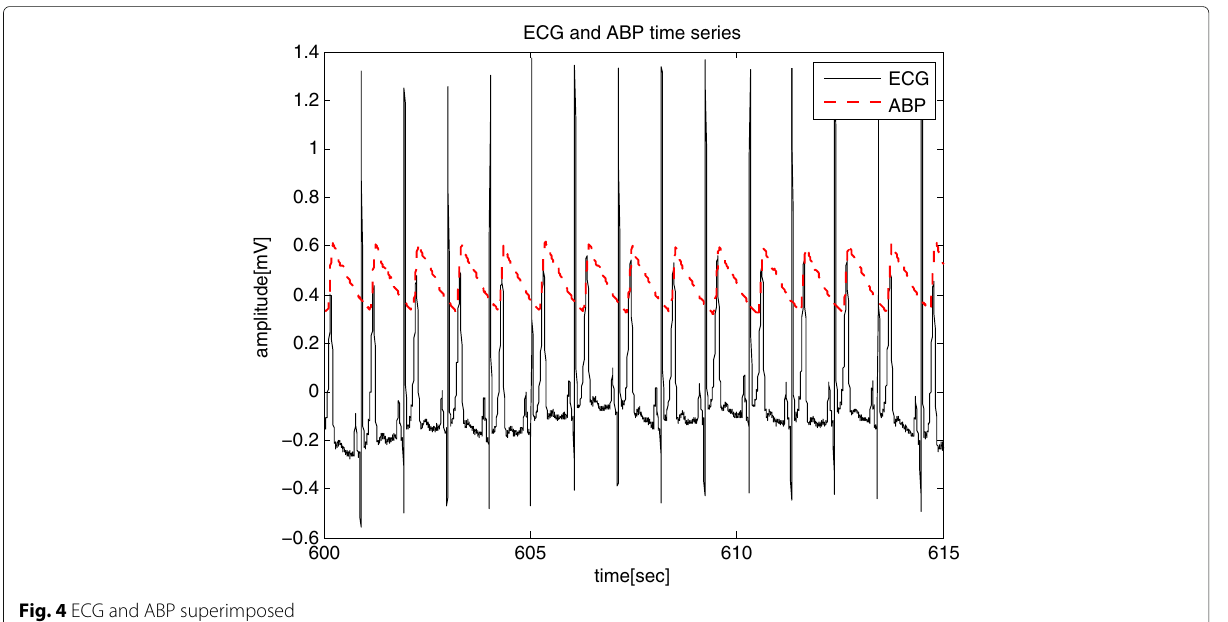
Fig. 4 ECG and ABP superimposed